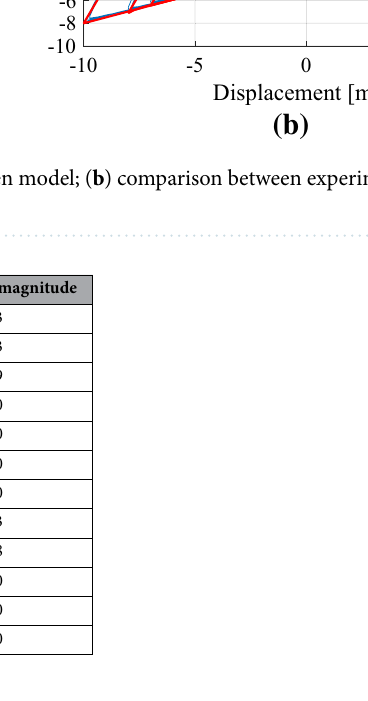
Table 2. Selected natural